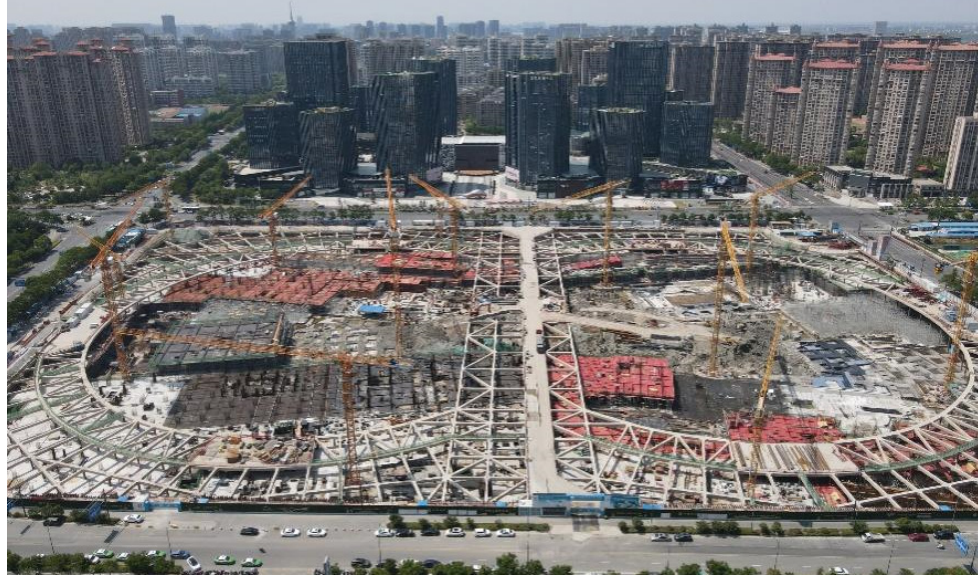
Figure 1. Aerial photograph of the foundation pit.